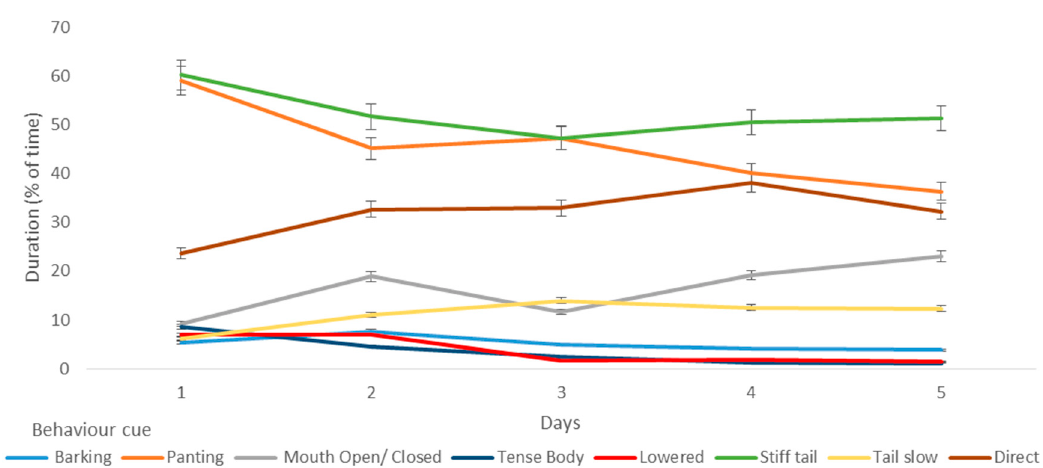
Figure 3. The duration of fear-related behaviours, arousal behaviours, and tail behaviours over the first five days that dogs ( n = 38) spent in a shelter.